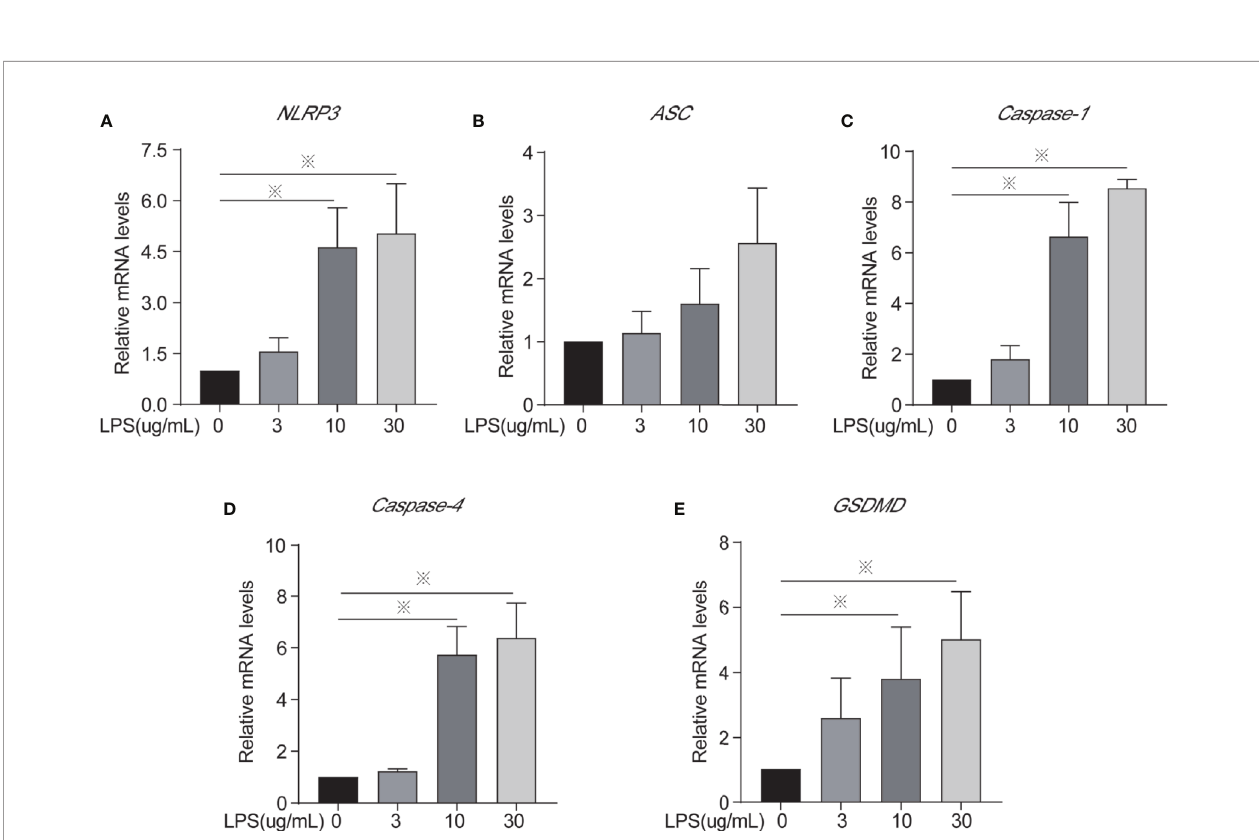
FIGURE 4 | In fl ammasomes mRNA expression of cells treated with different concentrations of LPS for 24 h. (A) NLRP3 , (B) ASC , (C) Caspase-1 , (D) Caspase-4 , and (E) GSDMD . Each treatment had three samples (n = 3) and was repeated three times to reduce system errors; “ ※ ” means there was a signi fi cant difference ( P < 0.05 ) compared with negative control (LPS, 0